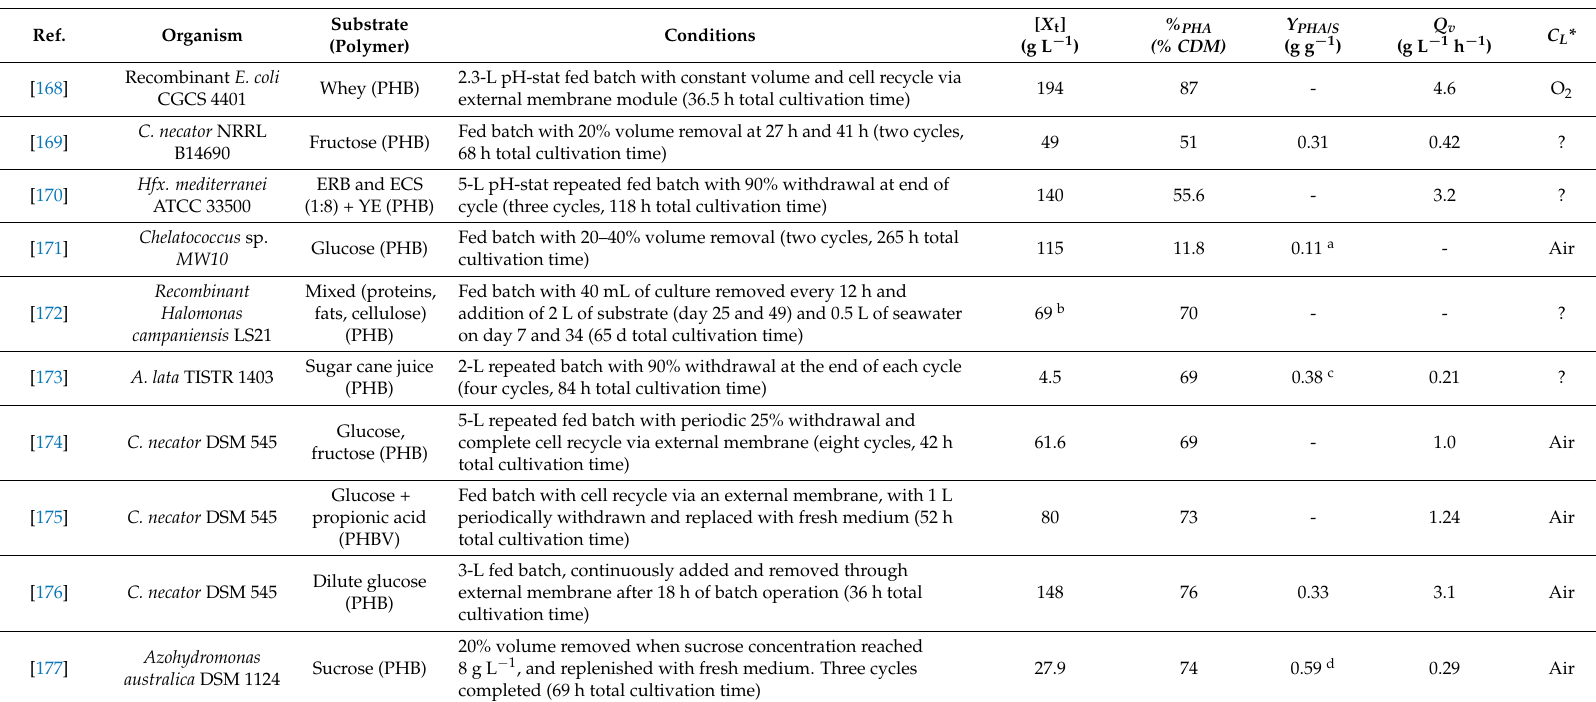
Table 6. Semi-continuous (cyclic) batch, fed-batch, and cell recycle processes applied in PHA production.